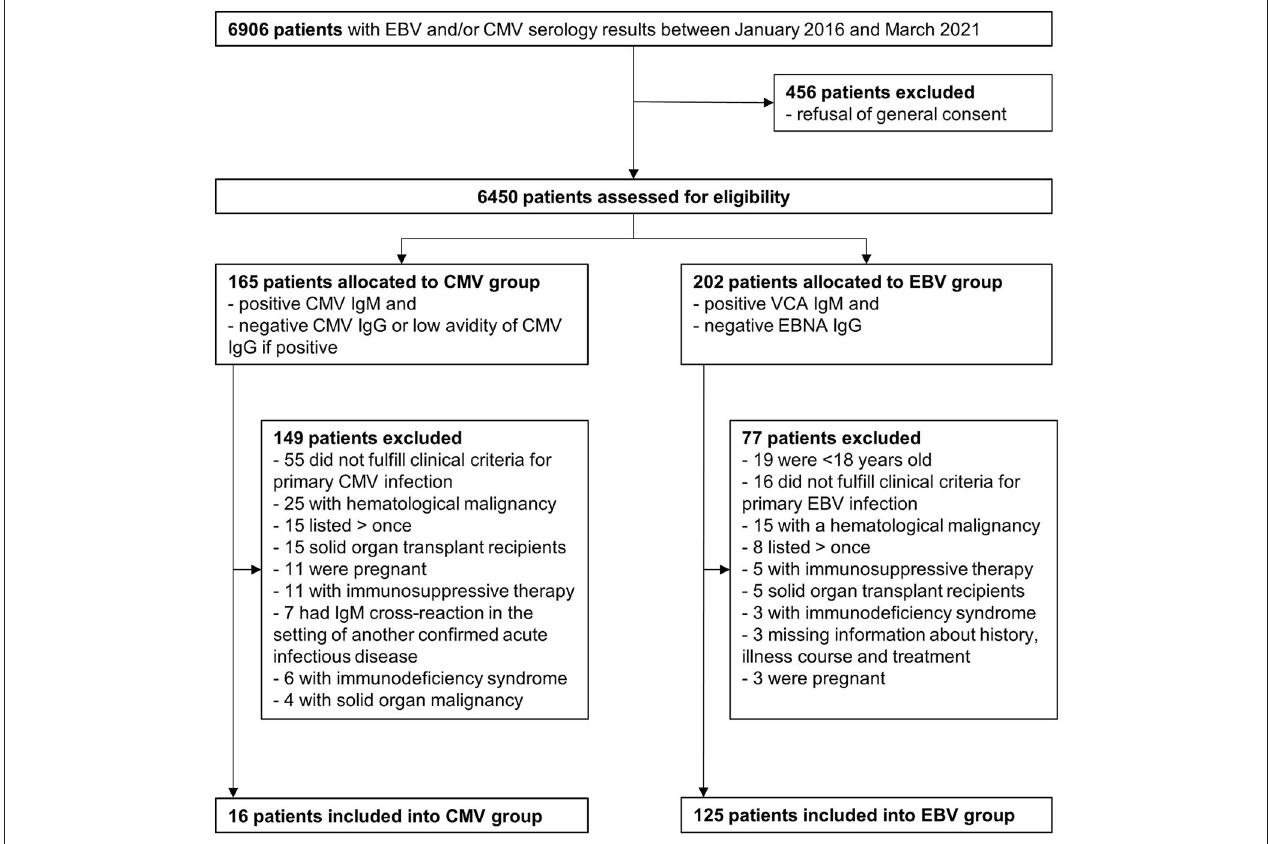
FIGURE 1 | Flow diagram of the